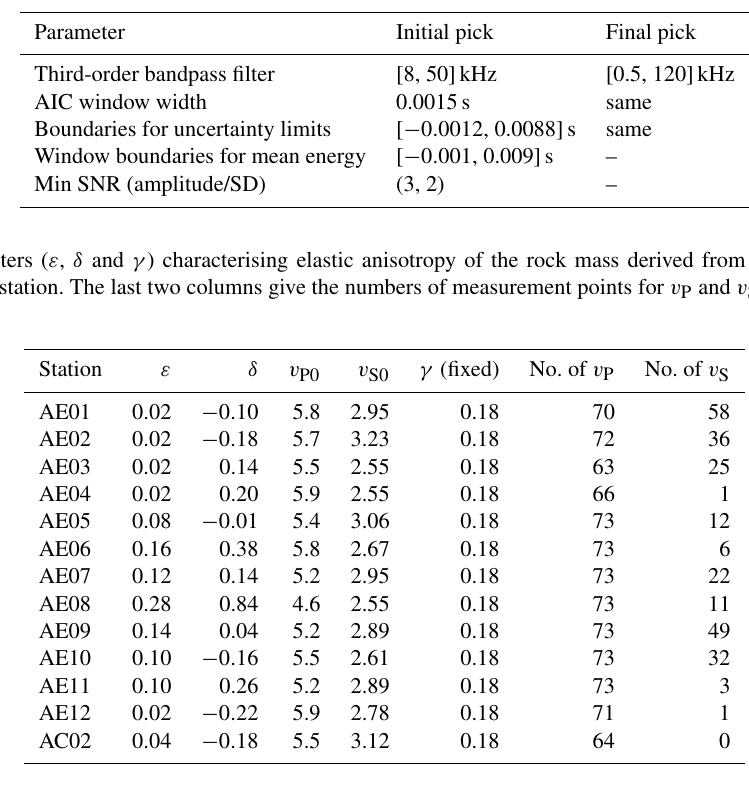
Table 4. Parameter setting for automatic picking routine.